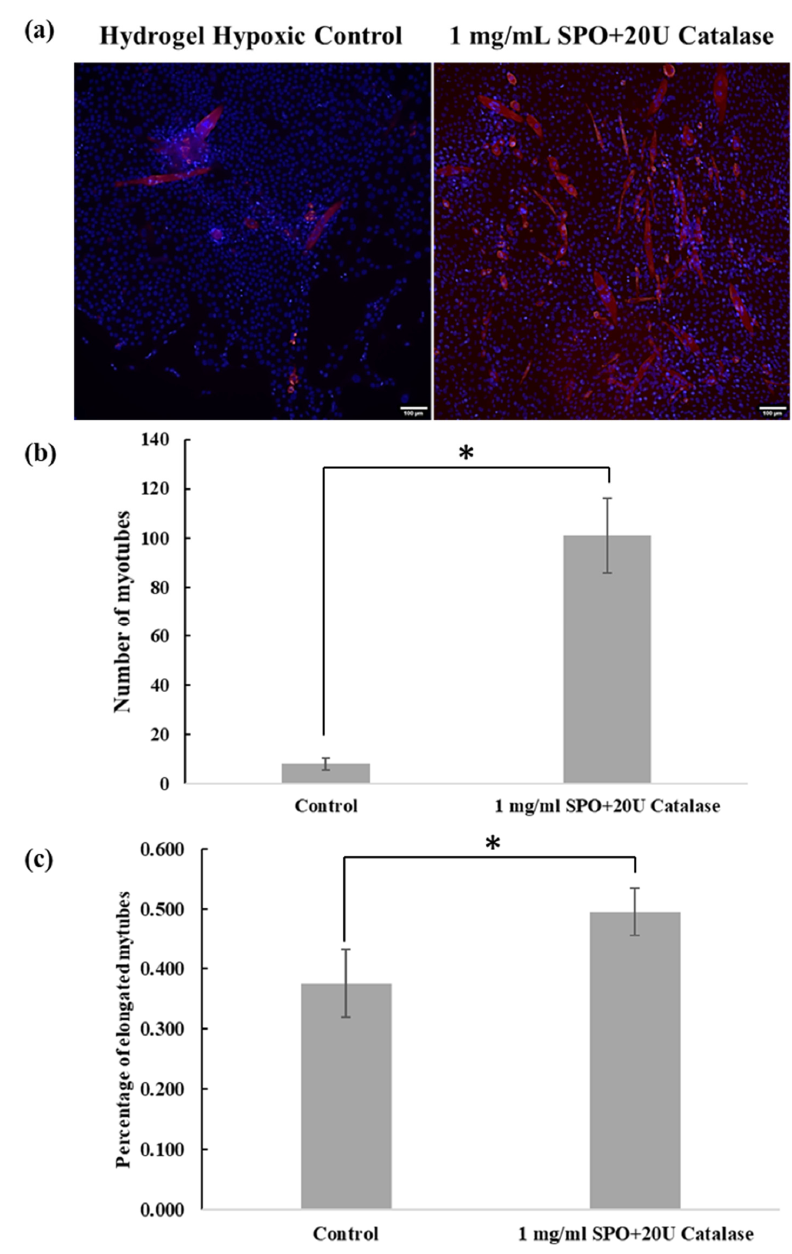
Figure 5. ( a ) Fluorescence images of myofibers using MF20 for bioprinted samples cultured for 8 days with control hydrogel and hydrogel with 1 mg/mL SPO/20 U catalase after transferal from hypoxic to normoxic conditions. ( b ) Quantification of total myotubes and ( c ) percentage of elongated myotubes based on fluorescence images.